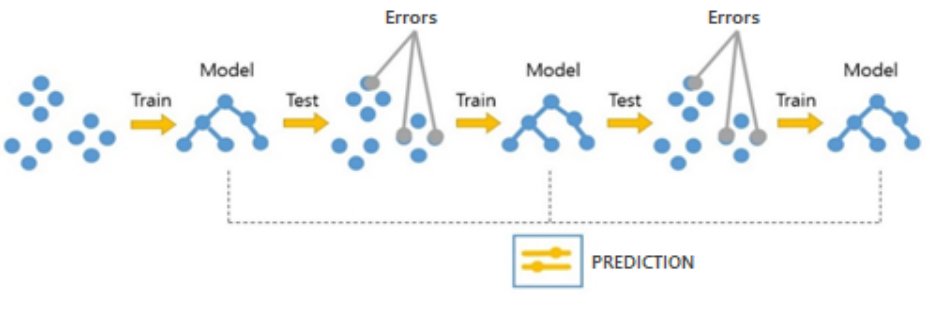
Figure 1. Model of gradient boosting.